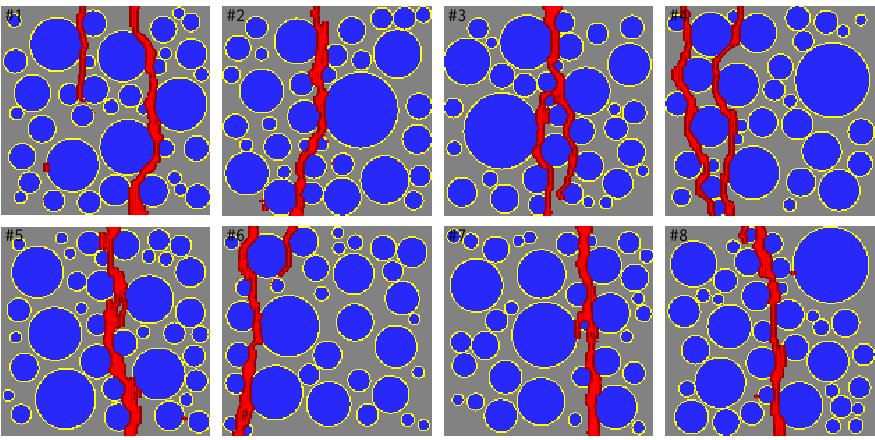
Figure 19. Crack pattern for selected specimens with P pore = 0% and P agg =